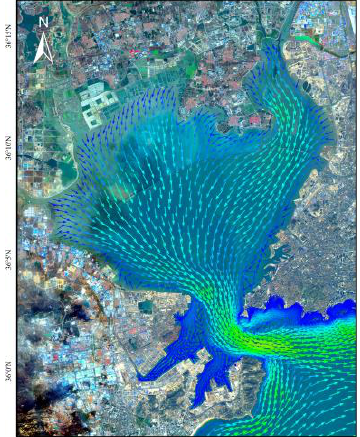
Figure 7 Jiaozhou Bay flow field diagram